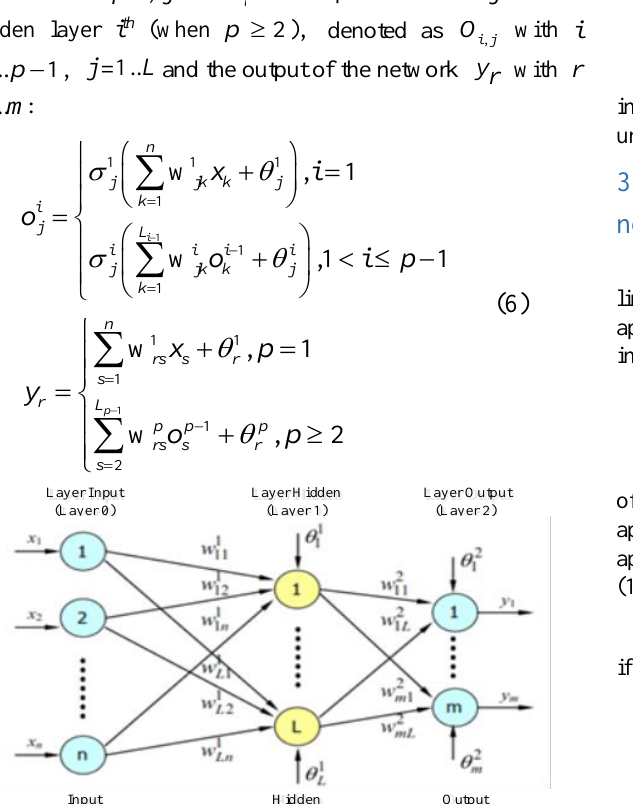
Figure 4. System 2-layer feed forward neural networks Figure 4 performances 2 layer feed forward neural networks (p = 2) has n input, m output linear and L buttons hidden. Network model is written as